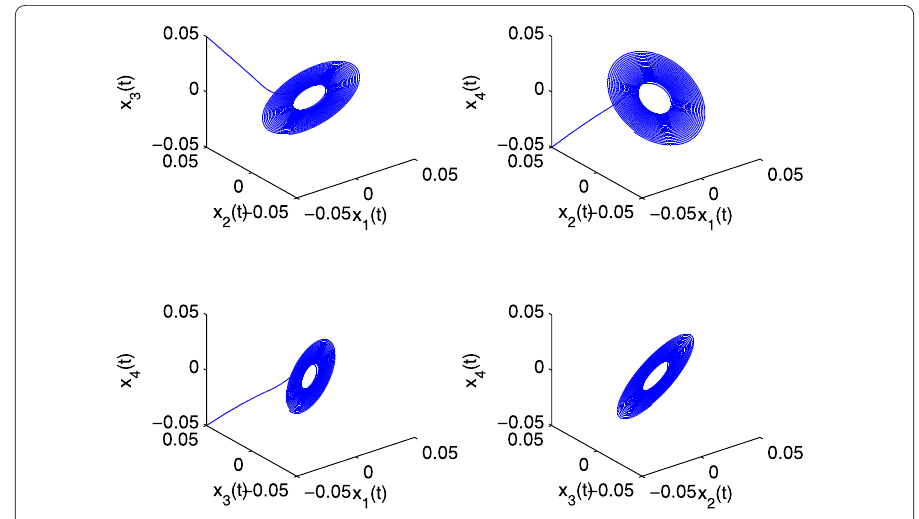
Figure 13 Phase portrait of system (5.3) with φ = 0.96, τ = 0.46 > τ 0 = 0.4486